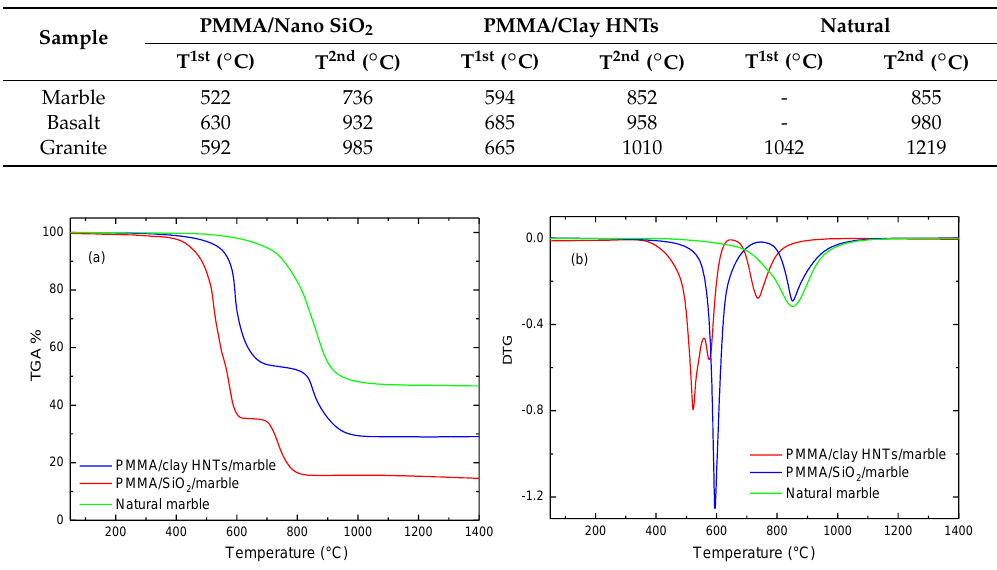
Table 5. The first and second phase transformation temperatures T 1st and T 2nd for the prepared artificial stones compared to natural stones.